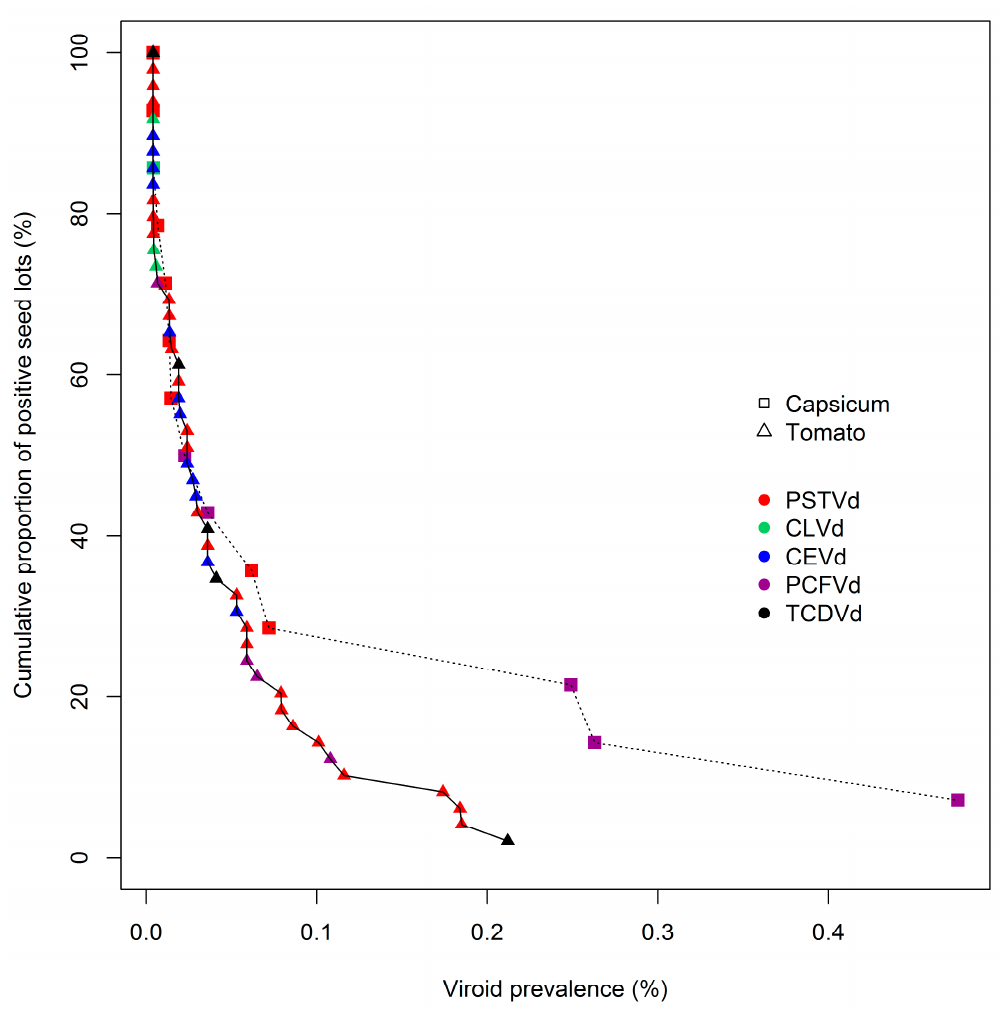
Figure 1. Cumulative distribution curves of viroid prevalences in contaminated tomato and capsicum seed lots presented for importation into Australia. Curves display the cumulative proportion by percentage (y-axis) of contaminated seed lots with viroid prevalences greater than, or equal to, the fractional rate (%) of prevalence identified on the x-axis. See text for full names of viroids.